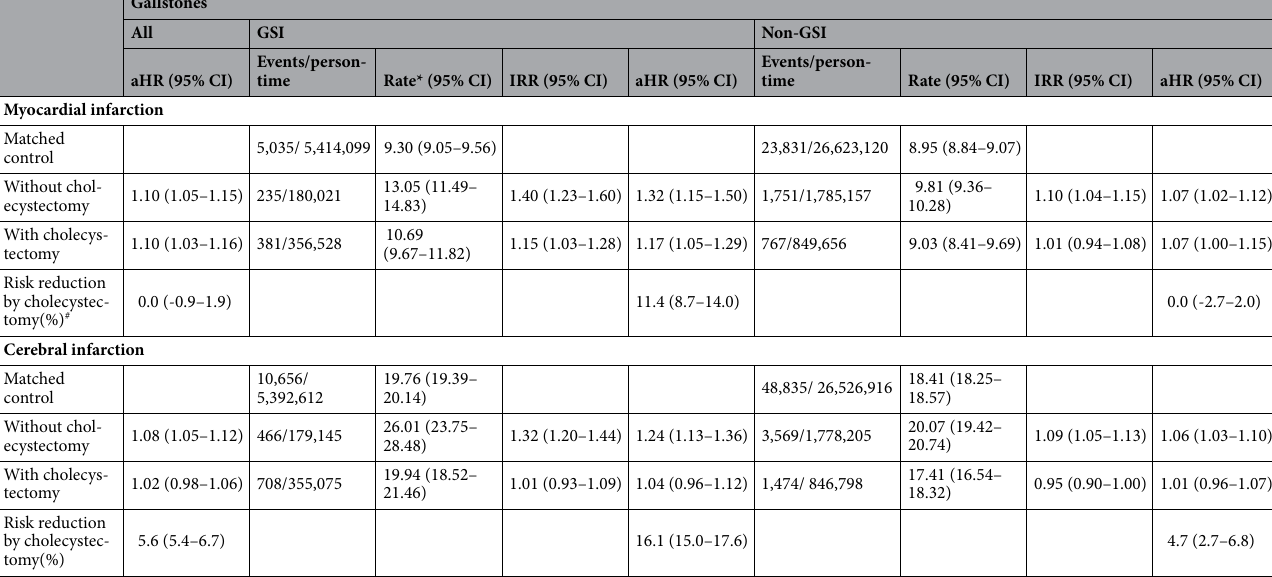
Table 2. Crude and adjusted risks of myocardial infarction or cerebral infarction according to gallstone- related infection and cholecystectomy. *, No. of events/10 4 person-time; GSI, gallstone-related infection; MI, myocardial infarction; CI, cerebral infarction; IRR, incidence rate ratio; aHR, adjusted hazard ratio; #, HR (C – C + )/C – × 100